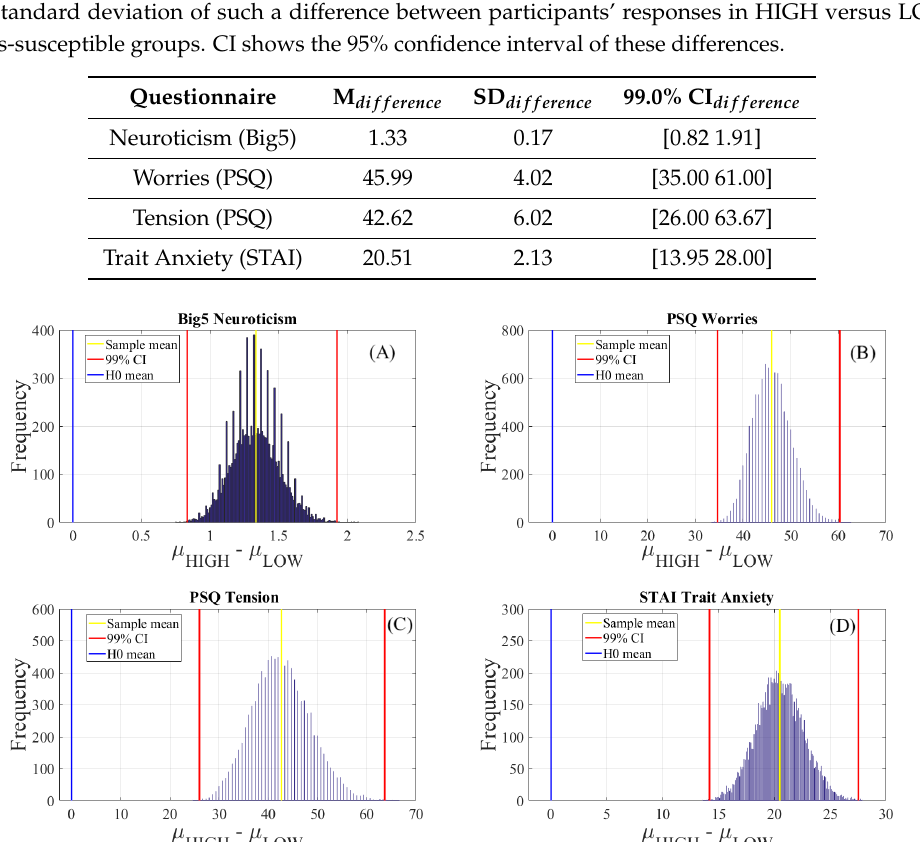
Figure A12. Paired two-sample bootstrap test of significance (10,000 simulation runs) at 99.0% (i.e., p < 0.01) confidence interval (CI) associated with responses of participants in HIGH versus LOW stress-susceptibility to questionnaires. ( A ) Neuroticism (Big5) ( B ) Worries (PSQ) ( C ) Tension (PSQ) ( D ) Trait Anxiety (STAI). In these subplots, the x-axis shows µ i − µ j , i (cid:54) = j (i.e., the difference between the two mean) where i and j refer to HIGH and LOW stress-susceptible groups, respectively. The blue line marks the null hypothesis H 0 i.e., non-significant difference between the responses of HIGH versus LOW stress-susceptibility. The red lines are the boundaries of the 99.0% confidence interval. The yellow line shows the location of the average of µ i − µ j , i (cid:54) = j (i.e., their differences) for 10,000 simulation